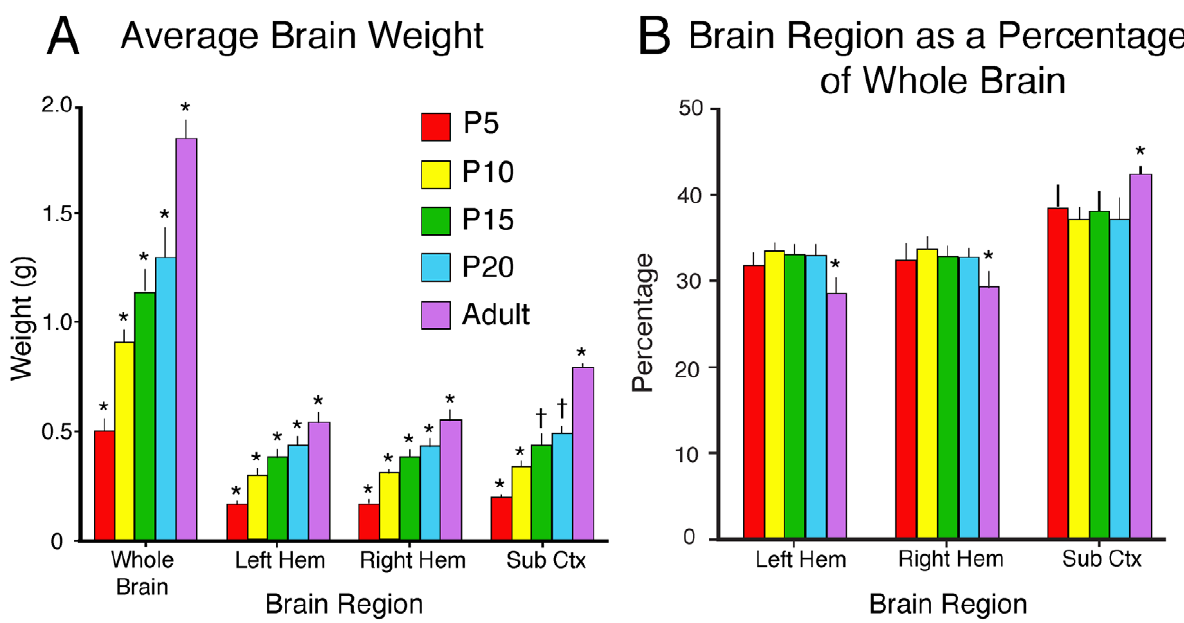
Figure 3. Changes in brain weight across development. A) Changes in the weight (in grams) of the whole brain, left hemisphere, right hemisphere, and subcortical regions across development. B) Changes in the weight of the left hemisphere, right hemisphere, and subcortical regions as a percentage of the weight of the whole brain across development. * - significantly different from all other ages. { - significantly different from P5, P10, and adult. Mean + s.d.